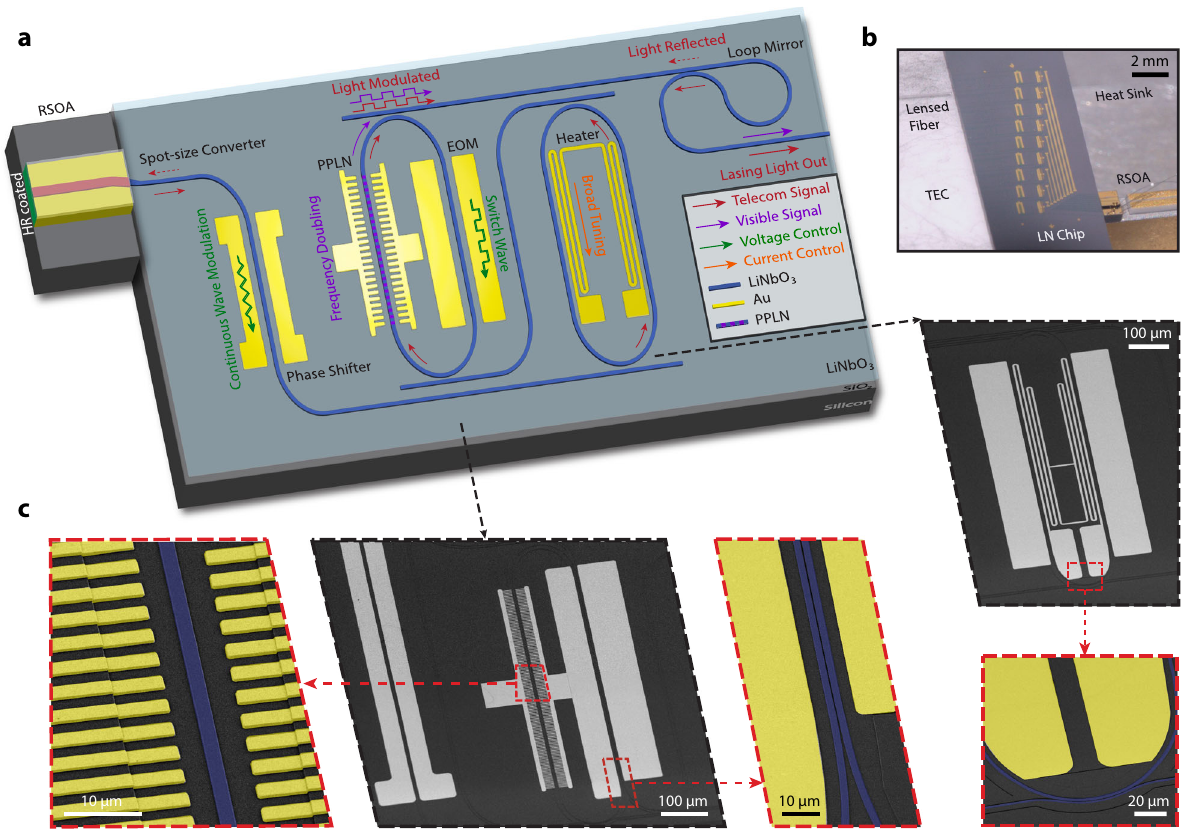
Fig.1|ConceptandstructureoftheintegratedPockelslaser.a Schematicofthe hybrid integrated laserstructure. b Photo of the setup with anRSOA edge coupled tothedeviceandsittingonheatsinks.Alensed fi bercouplesthelightoutfromthe device. The substrate is assembled by a thermoelectric controller (TEC) for